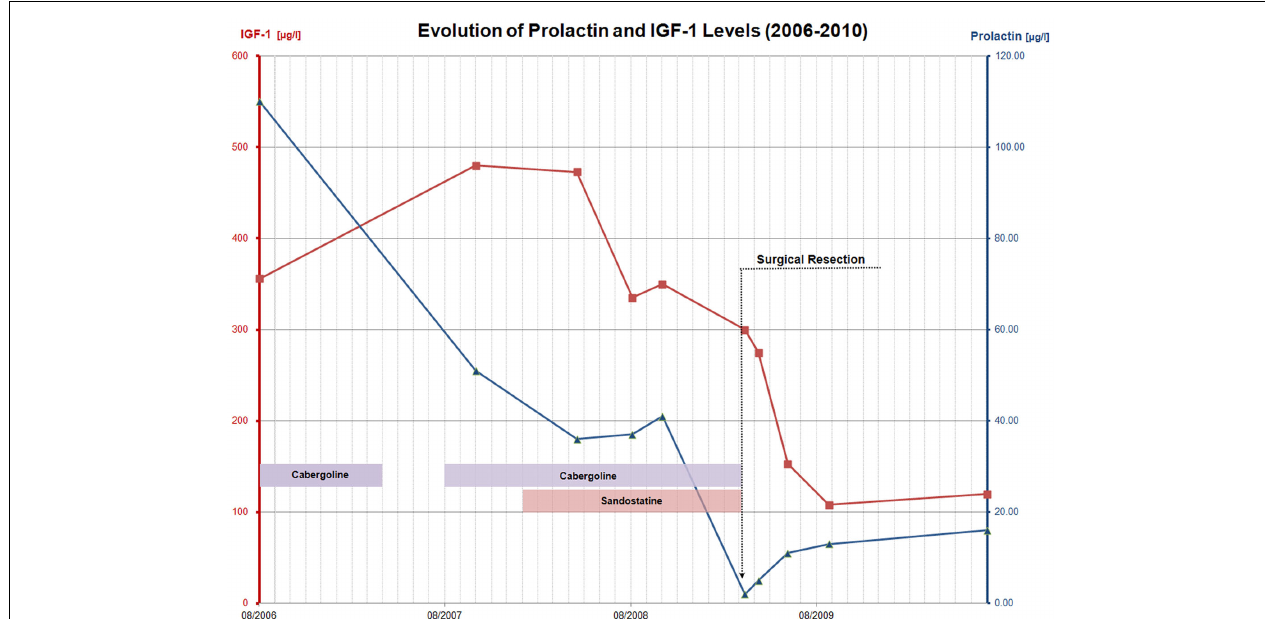
levels (squares) between 2006 and 2007, as well as the good response to long-acting octreotide therapy and the resolution of both IGF-1 and prolactin (triangles) hypersecretion after trans-sphenoidal